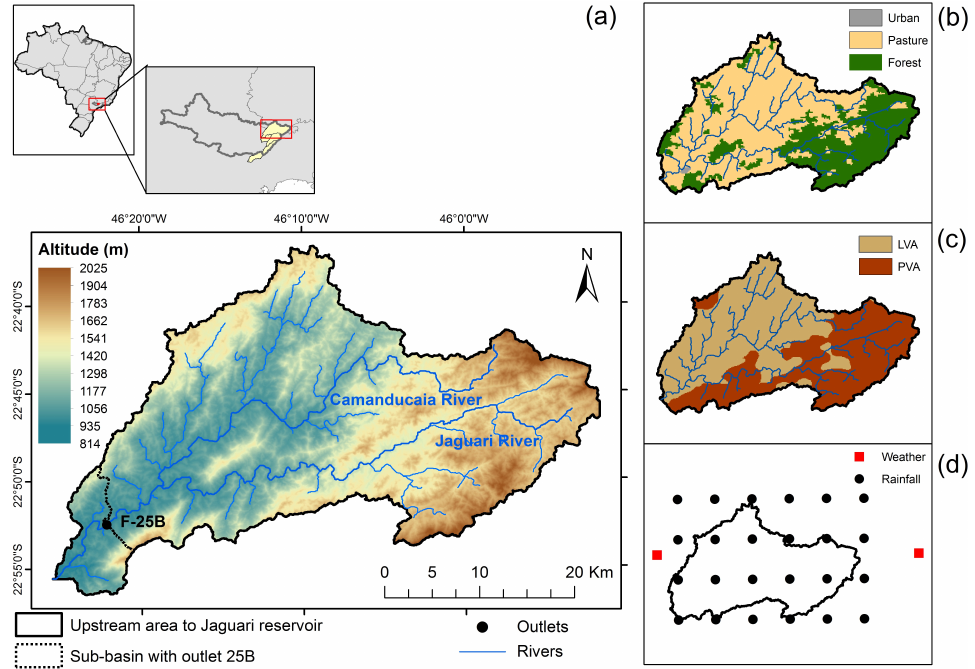
Figure 1. ( a ) Altitudinal map of the Jaguari river basin (m) with the outflow at gauge station F-25B (22.875 ◦ S and 46.369 ◦ W) within the Piracicaba river basin (grey shaded picture at top) and upstream the CRS (yellow shaded area at top). ( b ) Land use map; ( c ) soil map, where soil types LVA and PVA are Red-Yellow Latosol and Argisol, respectively; ( d ) location of rainfall (black circles) and weather (red squares)